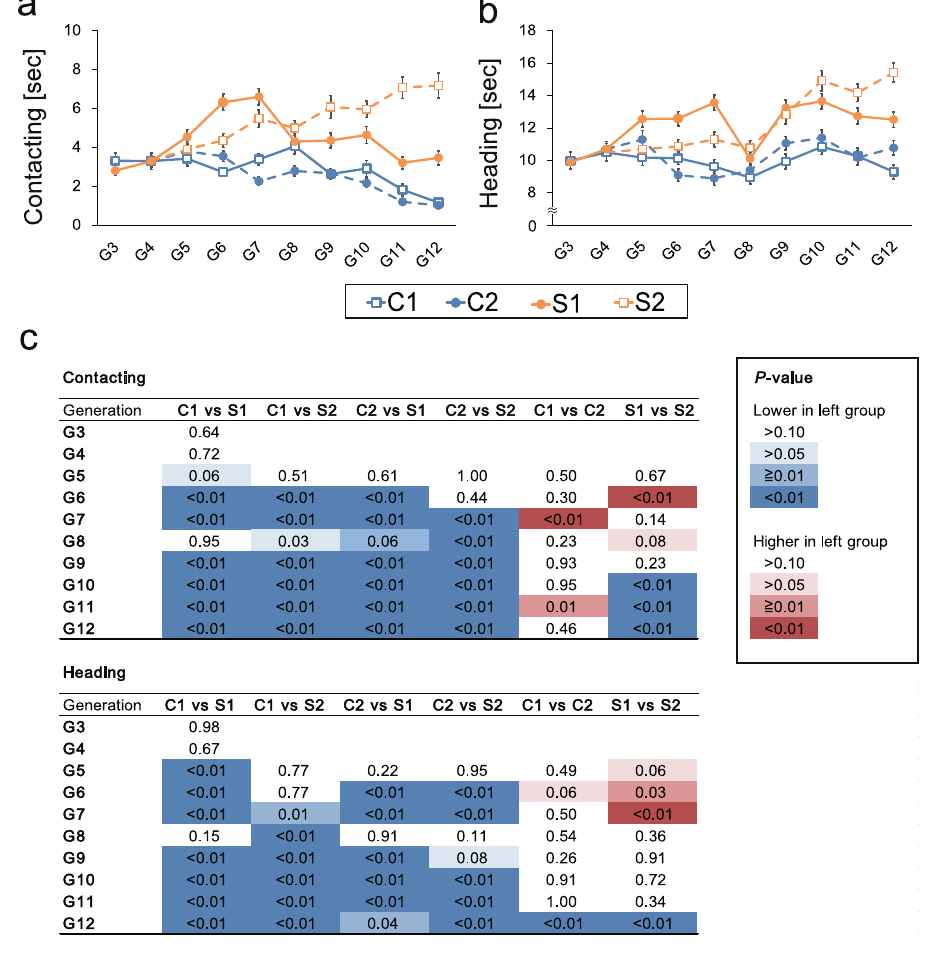
Figure 3. Results of selective breeding for active tameness using the wild-derived heterogeneous stock (WHS). ( a ) The fluctuations in the main selected behavioral trait “contacting” through the generations. The orange and blue lines indicate the mean scores of contacting in selection and control groups, respectively. The dashed lines indicate the split groups. Each dot represents mean score of contacting (n < 160 mice). The error bars indicate the standard errors around the mean (SEM). ( b ) The fluctuations in the second selected behavioral trait “heading” through the generations. The orange and blue lines indicate the mean scores of heading in selection and control groups, respectively. Each dot represents mean score of heading (n < 160 mice). The error bars indicate SEM. ( c ) The results of Steel–Dwass tests between two populations (generation G 3 –G 4 ) and four populations (generations G 5 –G 12